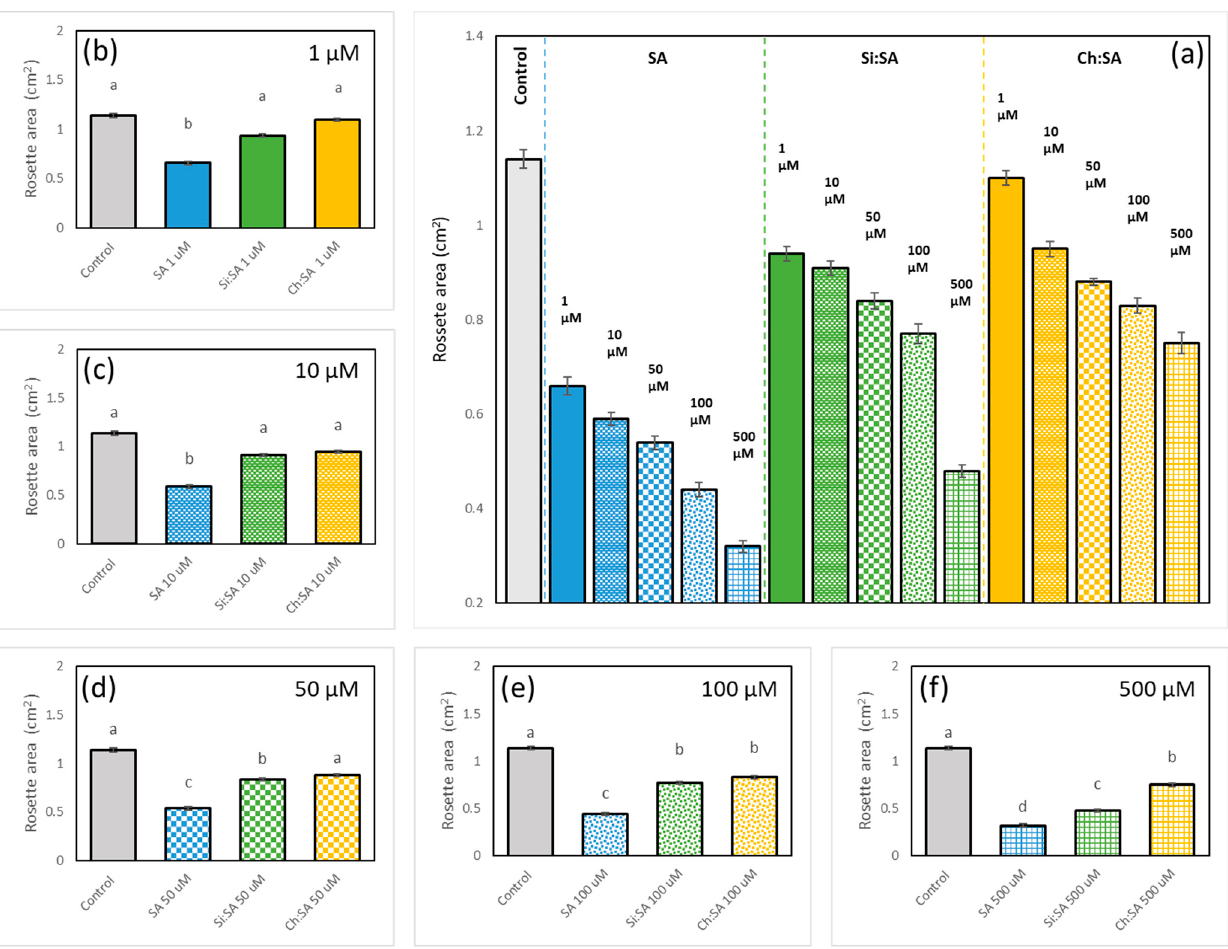
Figure 4. Effect of free SA, Si:SA and Ch:SA on the rosette size in Col-0 Arabidopsis plants. Five-day-old plants were transferred to media containing the different SA treatments and size was measured 5 days later. Graph ( a ) depicts the rosette area for the three treatments and at all doses, and graphs ( b – f ) compare the rosette area among the treatments at each dose (1 to 500 µM, respectively). Different letters indicate significant differences among treatment groups at p ≤ 0.05.